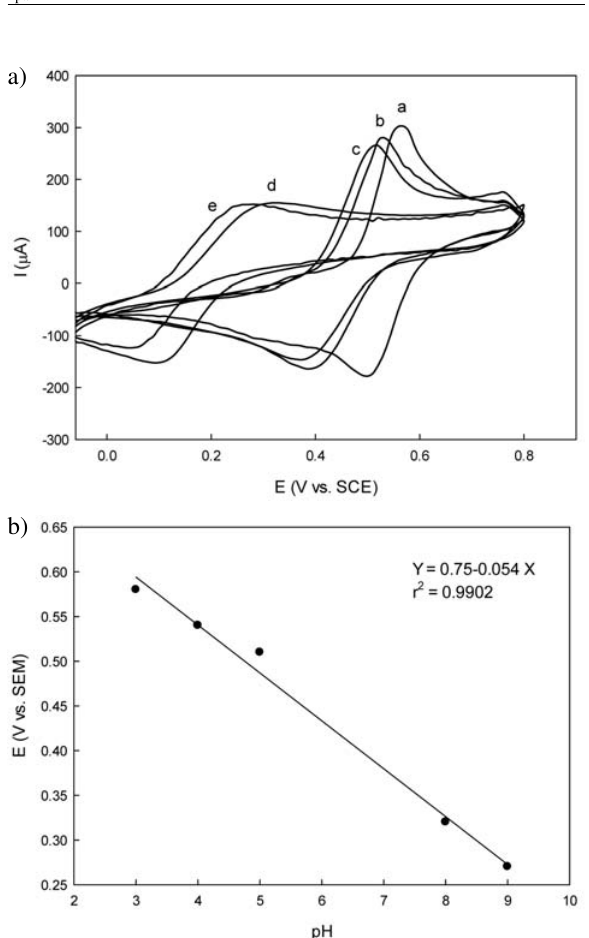
Figure 5. (a) CVs for Pt/PAAQ-SDS modified electrode in a phosphate buffer solution at different pH values containing 2.0 mM of catechol; pH: (a) 3, (b) 4, (c) 5, (d) 8, and (e) 9. (b) Linear beha- vior of anodic peak potential as a function of pH for electro-chemi- cal response of polymer film.